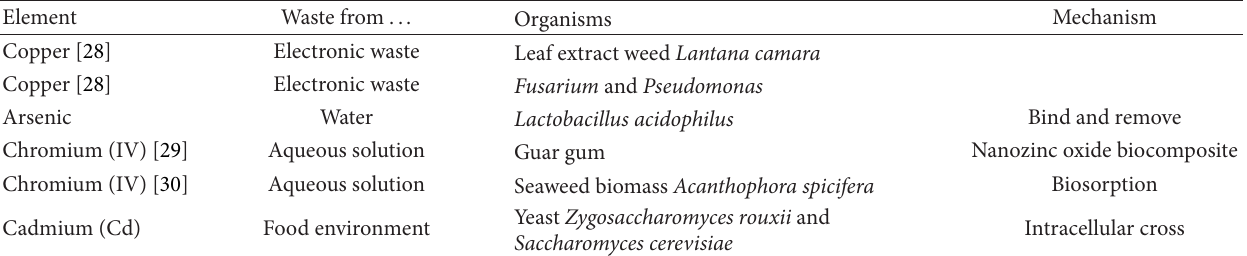
Table 1: Organisms that remove heavy metal from waste